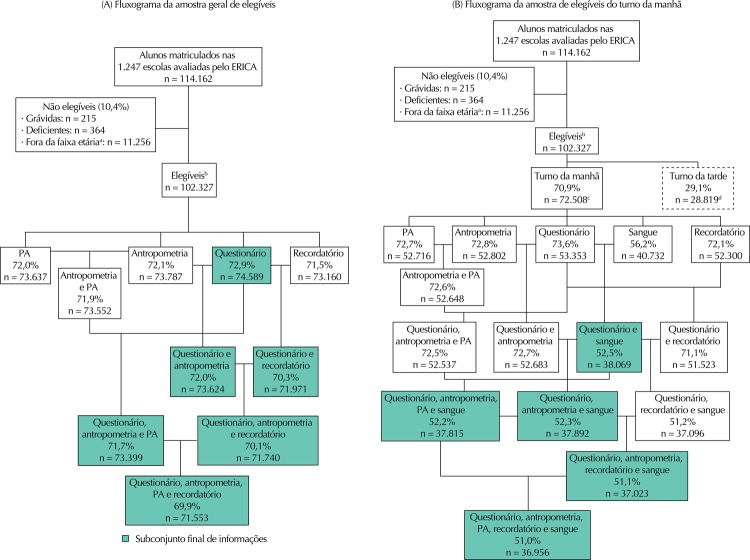
Fluxograma dos adolescentes elegíveis e completude da amostra em relação aos blocos de informações e subconjuntos de informações. ERICA, Brasil, 2013-2014. (Continua)ERICA: Estudo de Riscos Cardiovasculares em Adolescentes; PA: pressão arterial